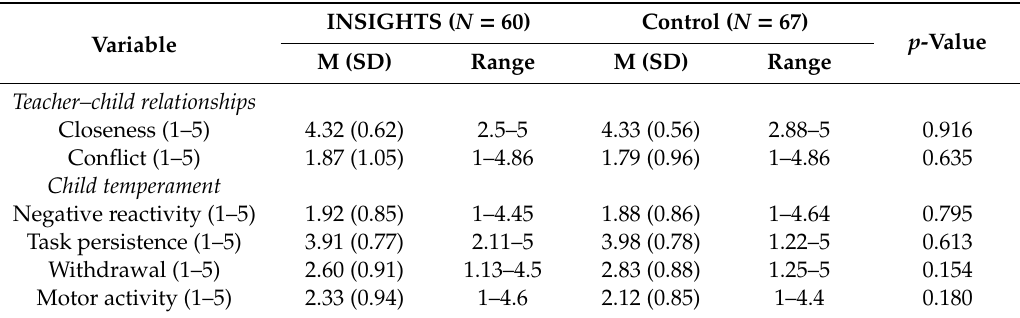
Table 3. Descriptive statistics for key variables at baseline (before INSIGHTS).